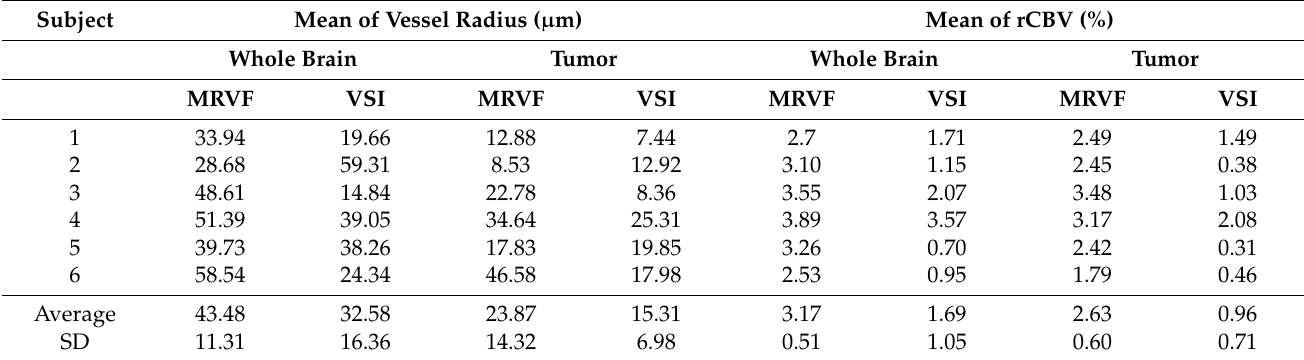
Table 3. Mean values of the vessel radius (in µ m) and rCBV (in %) maps, before adding noise, in the whole brain and tumor regions for MRVF and VSI techniques. The average and SD of the mean for each parameter and technique among the 6 subjects are also shown.